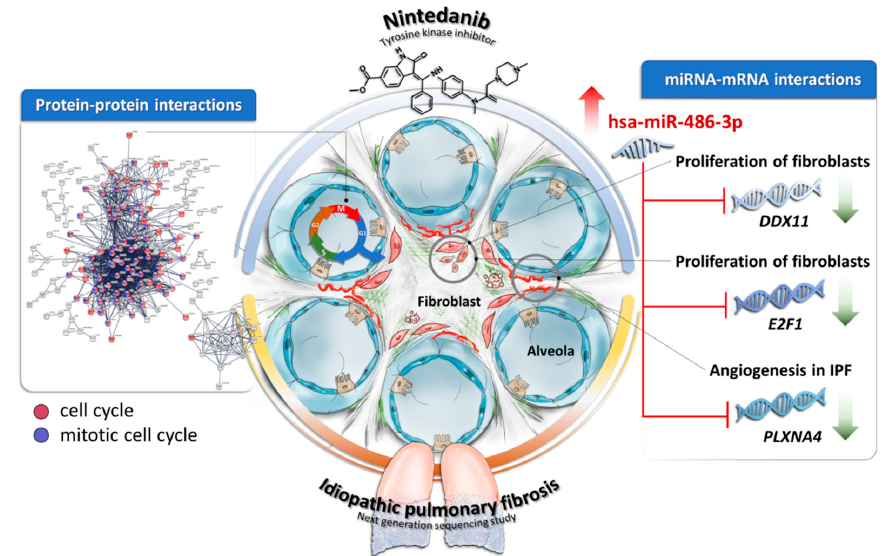
Figure 8. The schematic summary of gene expression changes and possible molecular mechanisms associated with nintedanib treatment in IPF fibroblasts. Strong protein–protein interactions was found within the dysregulated genes in nintedanib-treated IPF fibroblasts, with most genes involved in pathways of cell cycle and mitotic cell cycle. The upregulation of hsa-miR-486-3p might be associated with decreased expression of DDX11, E2F1, and PLXNA4 . These gene expression changes together might contribute to decreased proliferation of fibroblasts and decreased angiogenesis in the microenvironment of